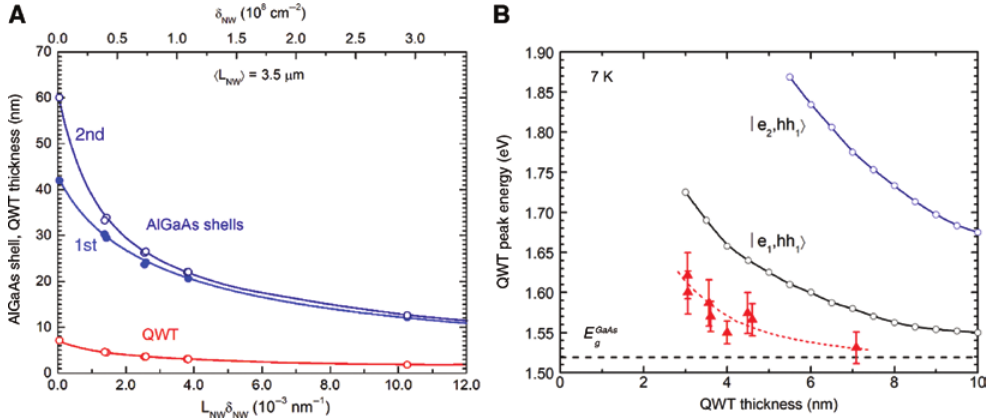
δ value, calculated based on NW NW ,hh ⟩ and |e ,hh ⟩ exciton transition energies for constant 1 1 2 1